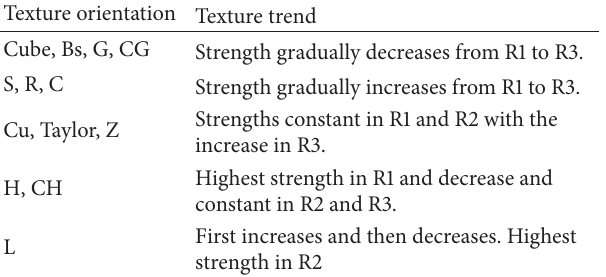
Table 2: Texture trend of final cold rolled gauge (from R1 to R3). Texture orientation Texture trend Cube, Bs, G,